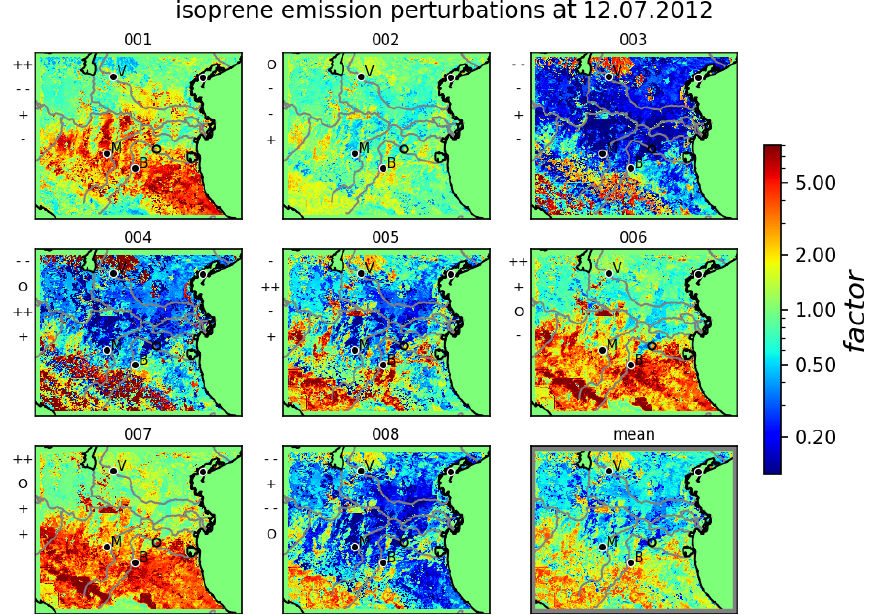
Figure 9. Perturbations of isoprene emissions for independent sensitivities, including additional uncertainties given as factors w.r.t reference emissions. Random realizations of stochastic coefficients for the leading eigenmodes of each member are indicated left of each subplot: + + , large positive value ( > 1 . ); + , small positive value (0 . 1 < ∗ < 1 . ); O, very small absolute value ( − 0 . 1 < ∗ < 0 . 1); − , small negative value ( − 1 . < ∗ < − 0 . 1); − − : large negative value ( < − 1 . )). The lower-right subplot gives the ensemble mean factors. Some major cities (Verona, Bologna, Modena) are indicated by their initial